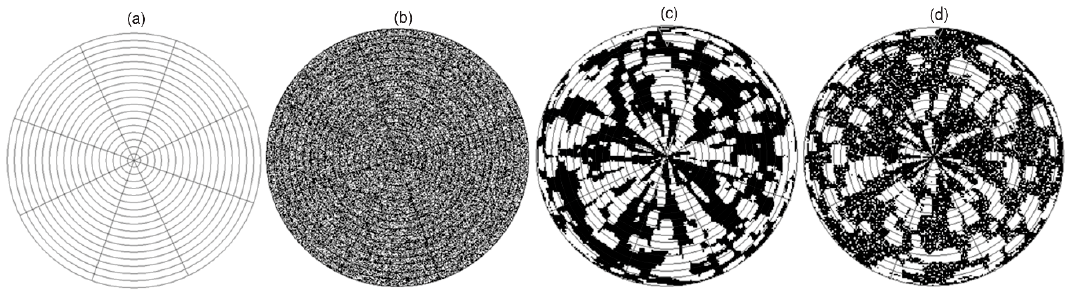
Figure 5. Skymap sectors ( a ), R ( b ), C ( c ) and RC ( d ) gap patterns for Sim-TLS-SHI.